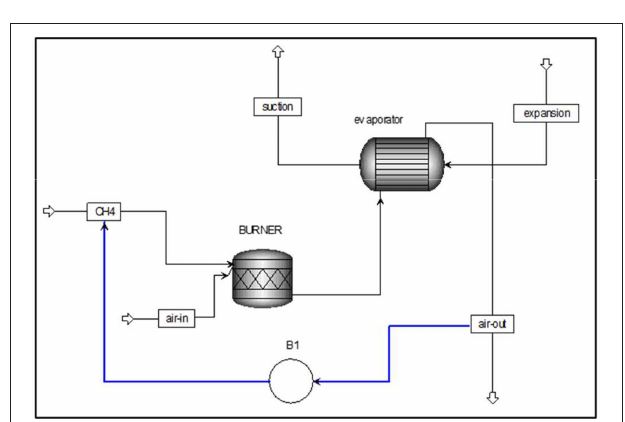
FIGURE 10 | Schematic diagram of the dynamic model for control strategy